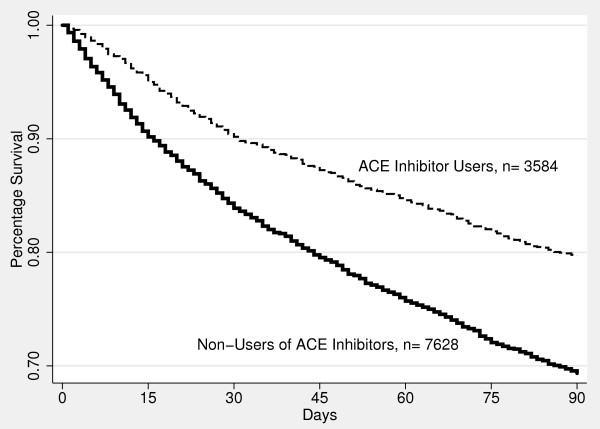
Proportion of surviving patients hospitalized with COPD exacerbation by use of ACE inhibitor versus non-use (p < 0.001).